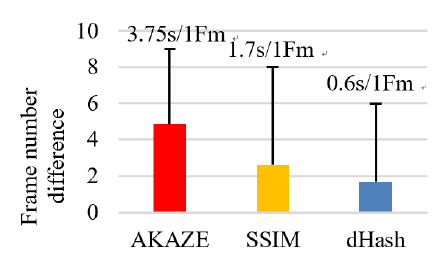
Figure 3. Frame error from the reference image